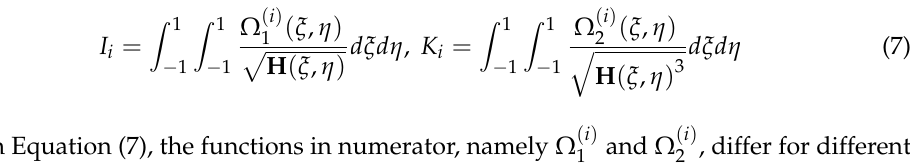
Figure 2. Integrand variations of ( a )